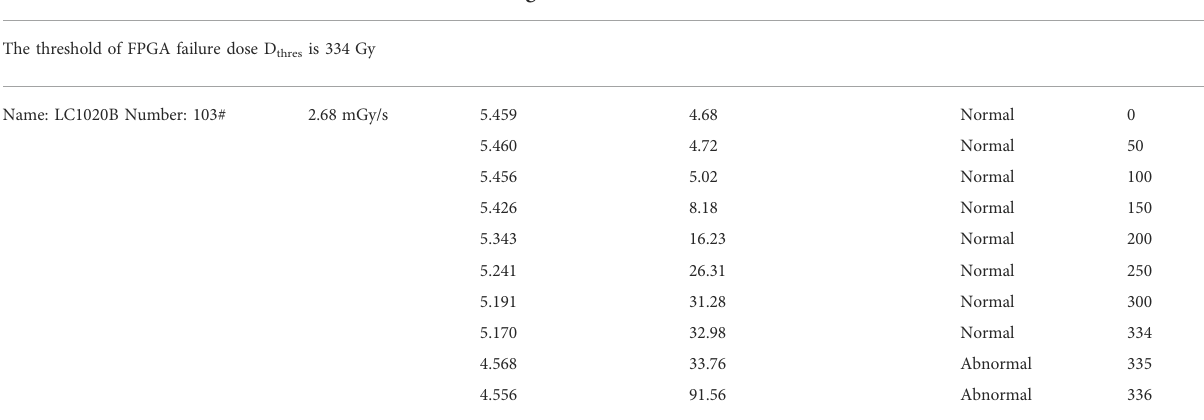
Power consumption Function Dose/Gy voltage/V current/mA